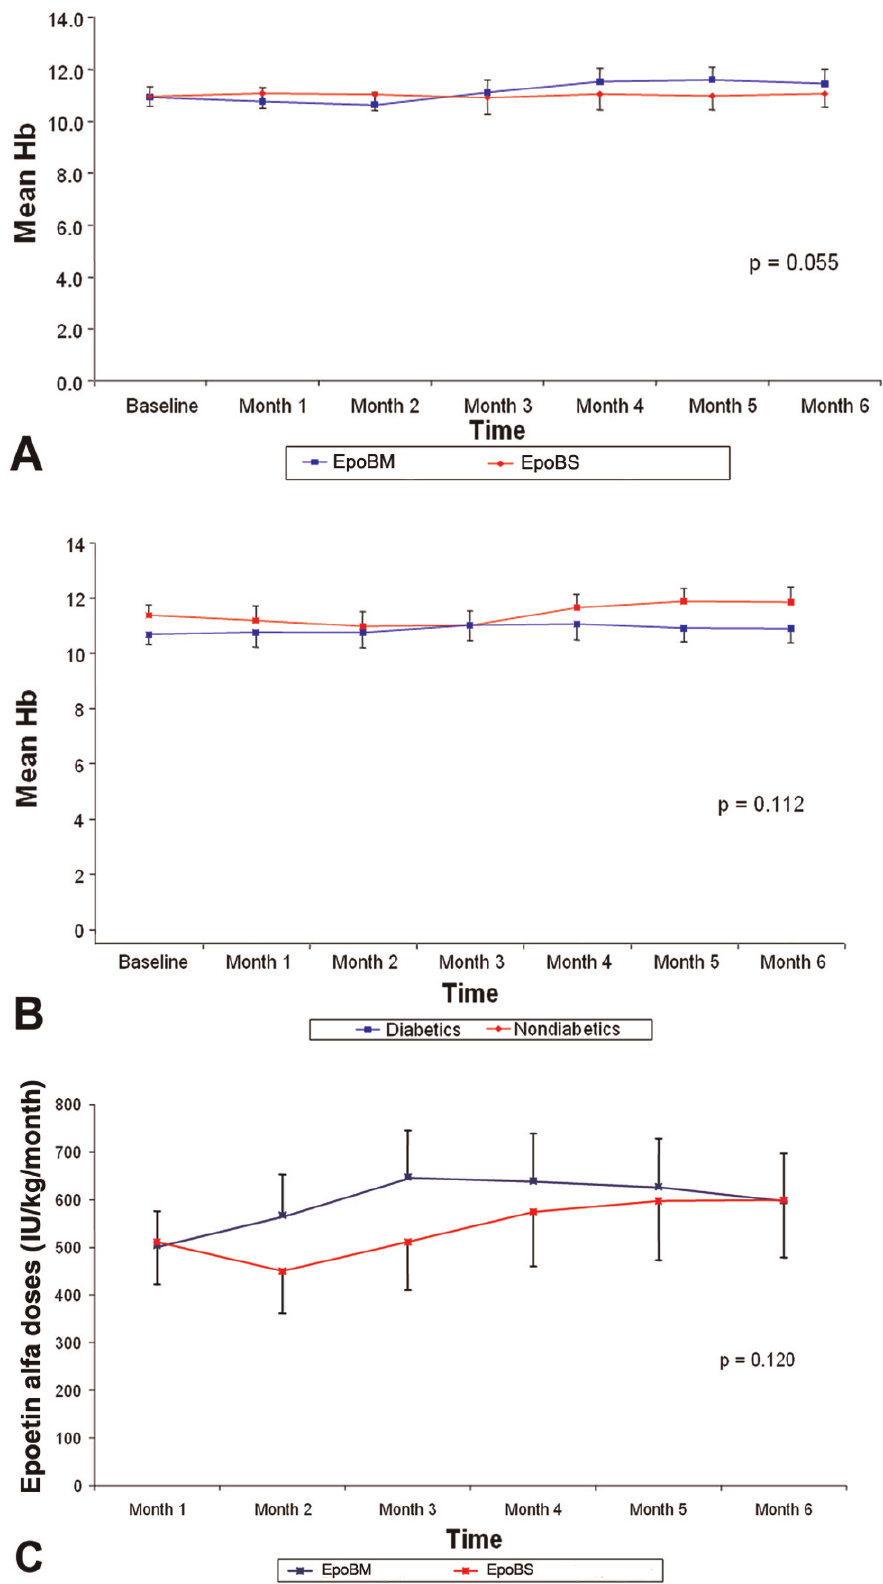
Figure 2 - Mean hemoglobin levels during the 6-month follow-up in (A) the groups receiving Bio-Manguinhos epoetin (EpoBM) or a commercially available biosimilar formulation (EpoBS) and in (B) diabetic and nondiabetic patients. (C) Mean monthly doses of epoetin alfa in the EpoBM and EpoBS